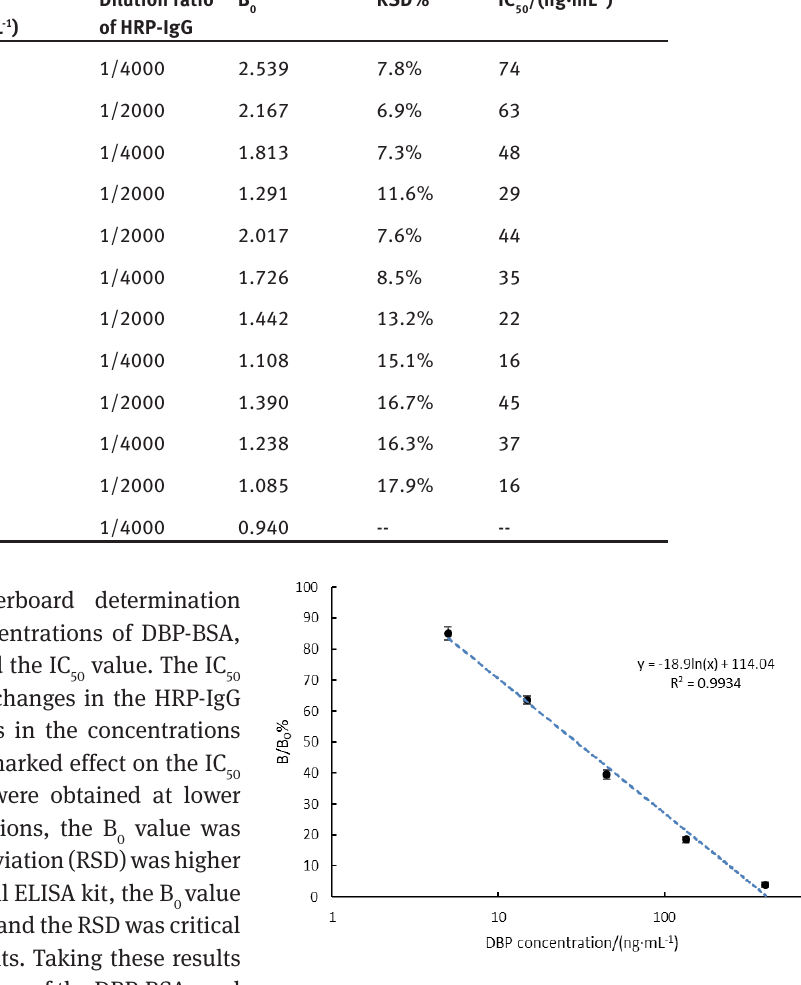
Table 1: Optimization of concentrations of coating antigen, antibody and IgG-HRP. Concentration of